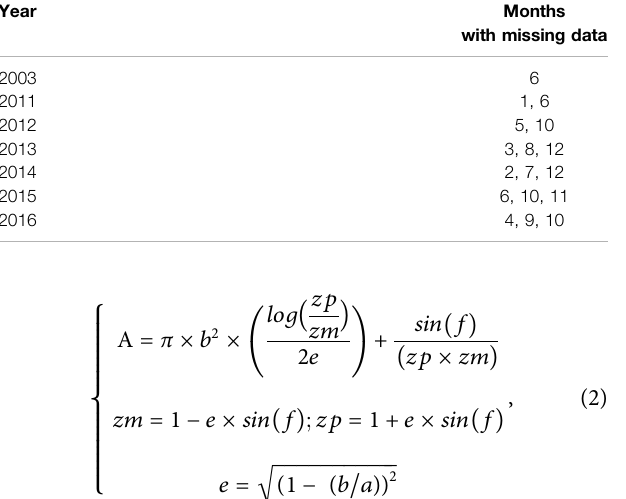
TABLE 1 | Date with missing GRACE